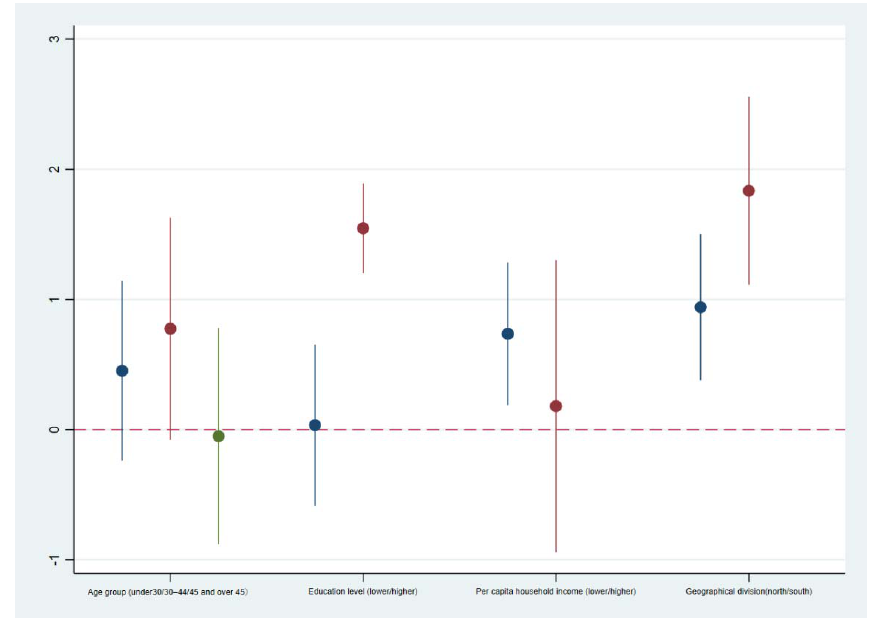
Figure 3. Heterogeneity effect of smog avoidance investment on household health care expenditure. The Exp parameter (±1.96 SE) estimated for each group of samples in Table 4 model (4) is shown.